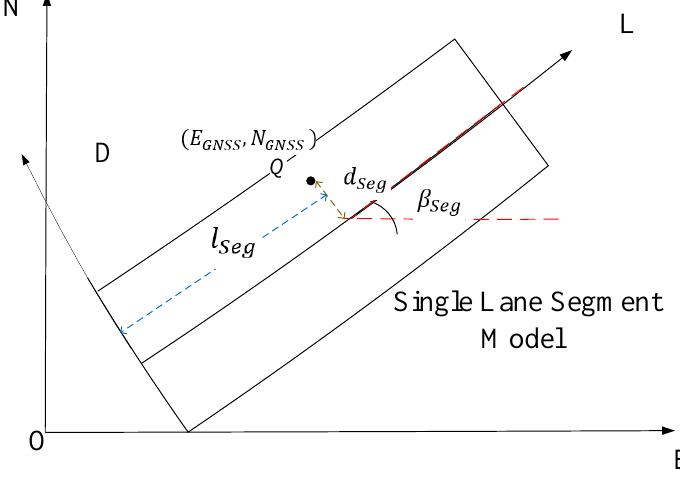
Figure 2. The defined single lane segment model.